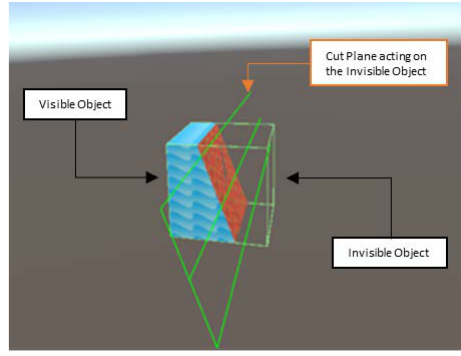
Figure 4. Ghost cut of the left-hand side provided by the original algorithm.